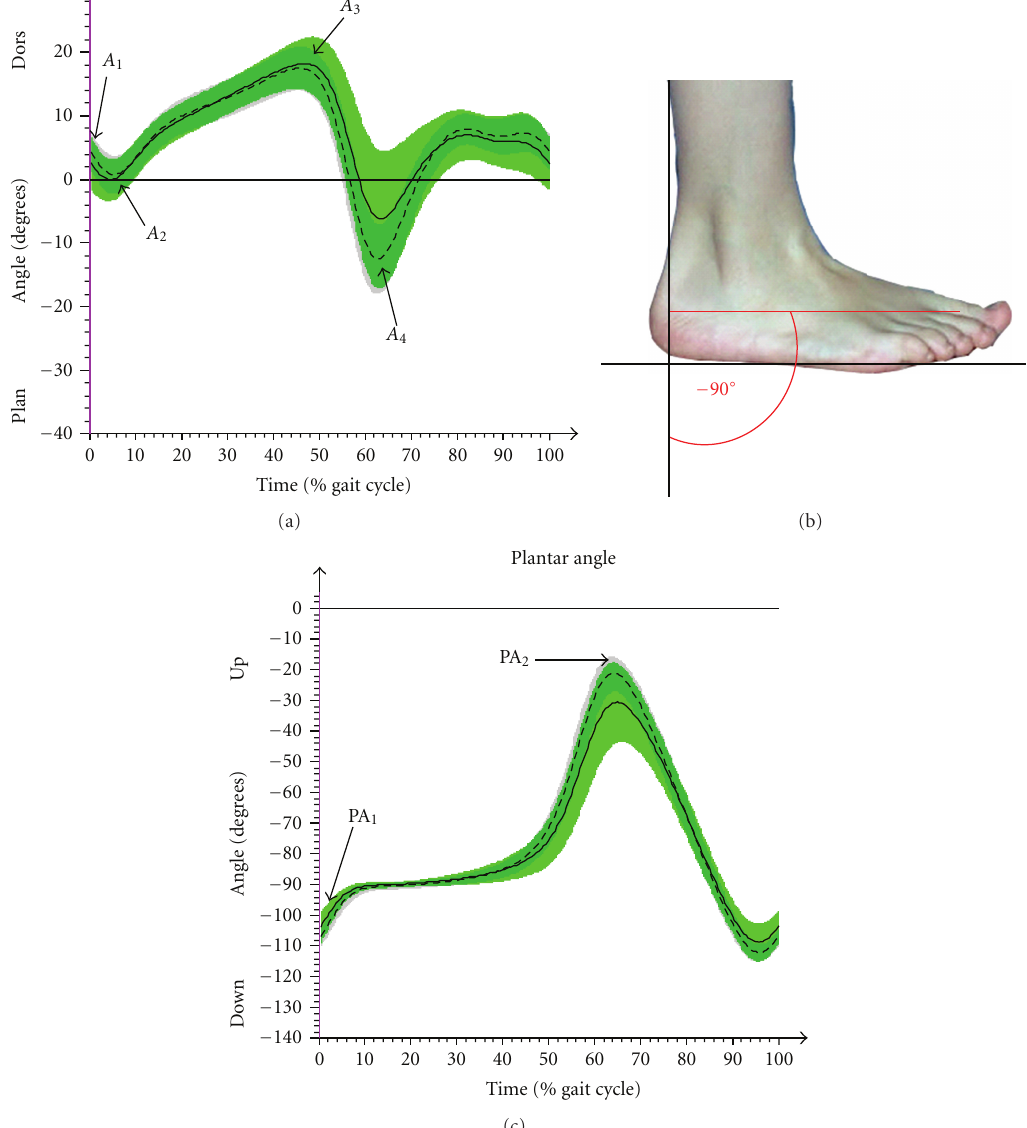
in the contralateral drop of the pelvis from initial contact to maximum height during loading response (Figure 3) ( P < .05). There were no statistically significant results in the ROM of pelvic rotation (Table